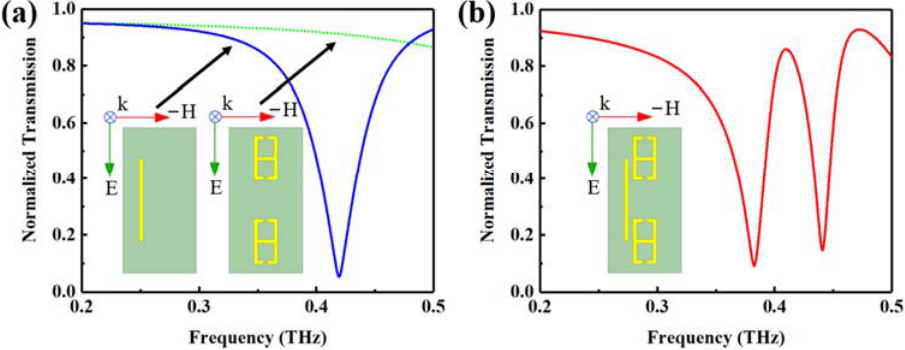
Figure 3. ( a ) Normalized transmission curves of the CW (blue solid line) and ELC resonators (green dotted line). ( b ) Normalized transmission curve of the proposed EIT MTM. The insets and coordinate systems show the corresponding unit cells and the polarization direction of the incident waves.